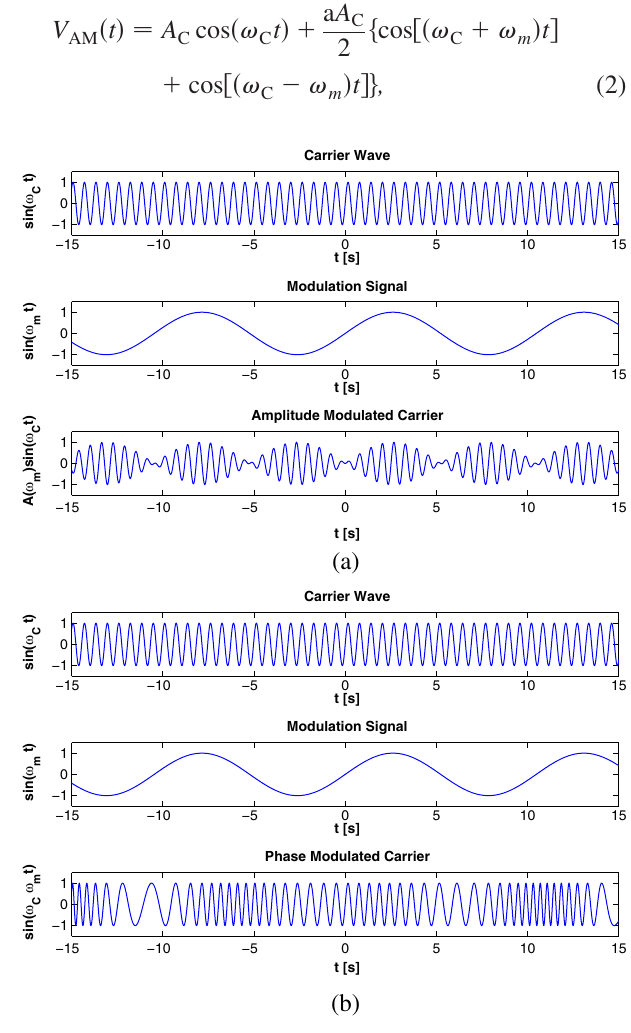
FIG. 1. Example for amplitude (a) and phase (b) modulation of a carrier wave.